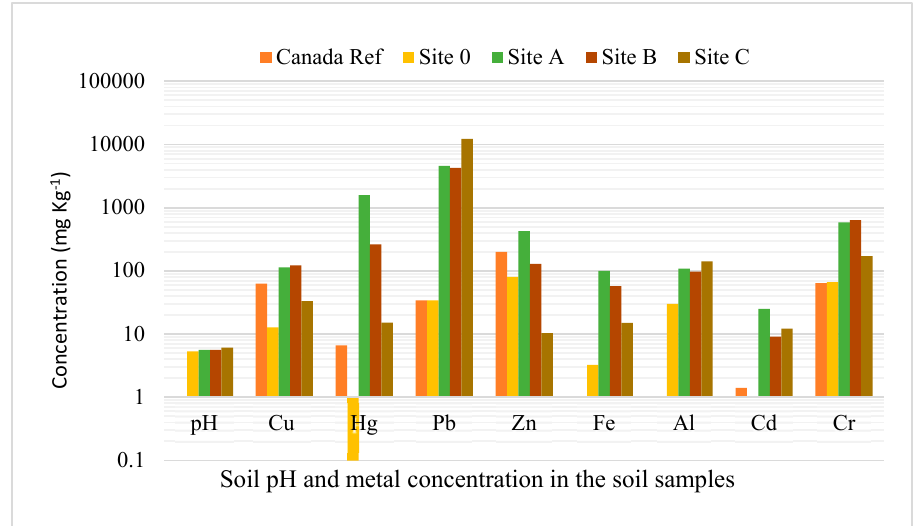
Figure 3. Variation in the concentrations of heavy and toxic metals in the investigated site compared with background and reference values.